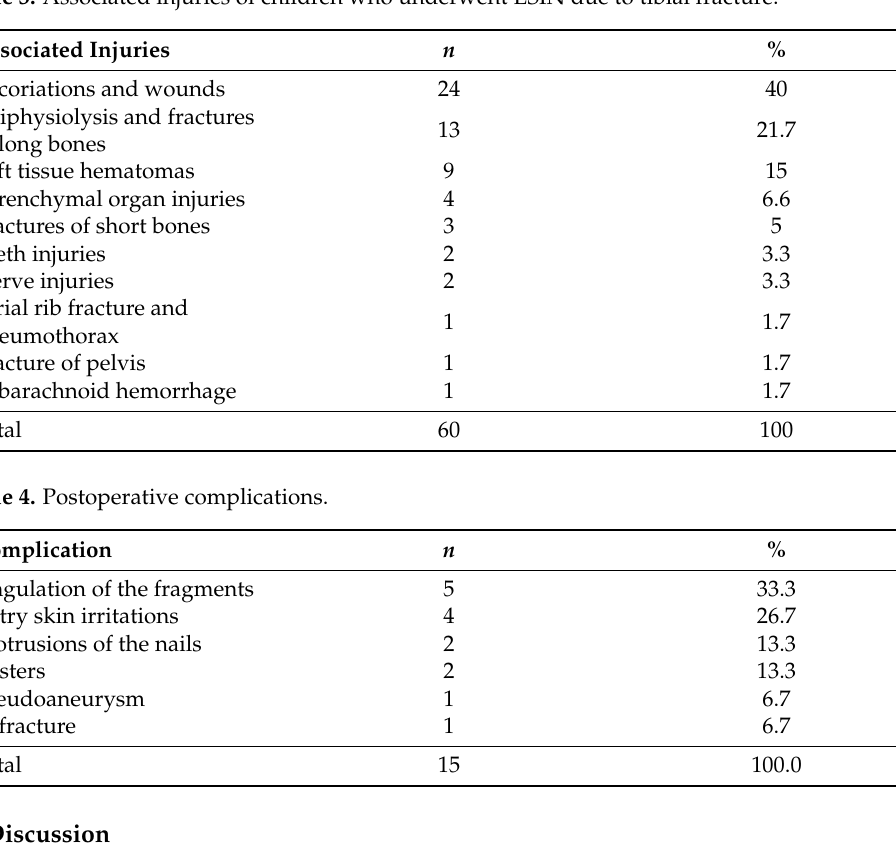
Table 3. Associated injuries of children who underwent ESIN due to tibial fracture.